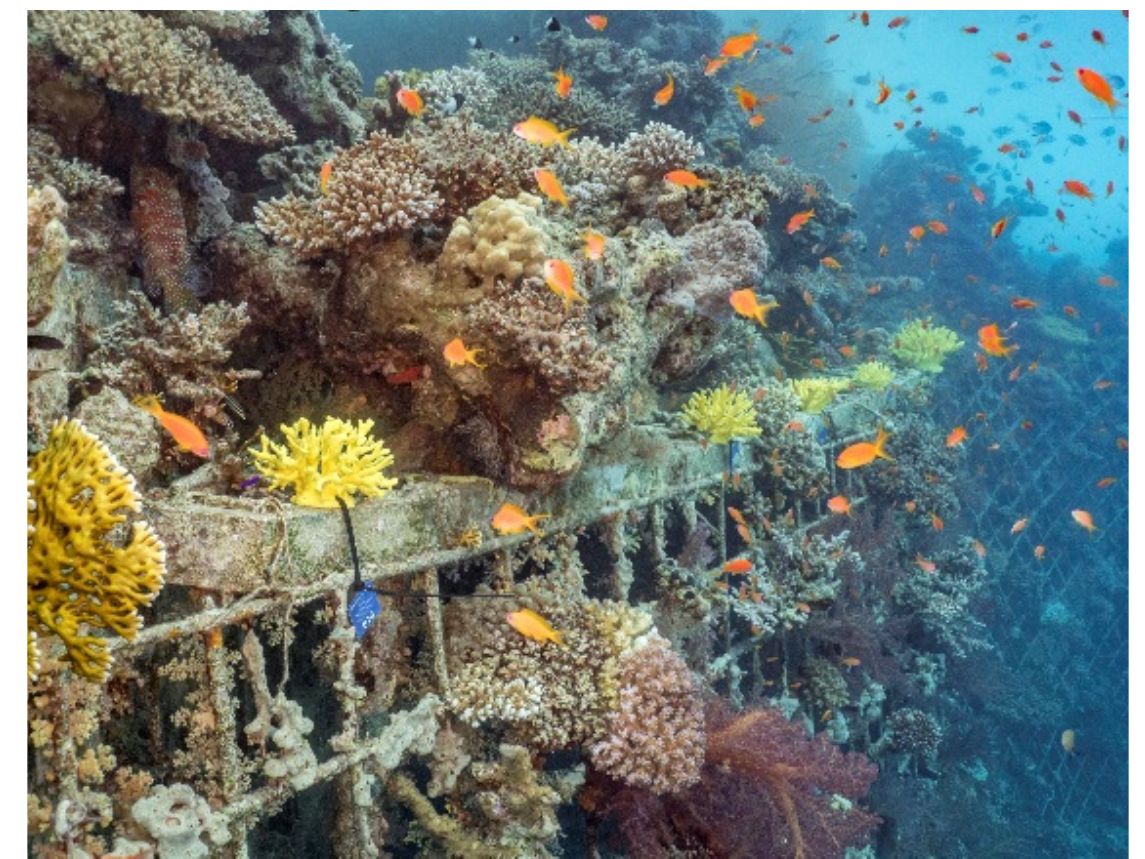
Figure 4. Fishes’ preference of shelter structure experiment set-up. Note 5 yellow coral models, each with their own structure.